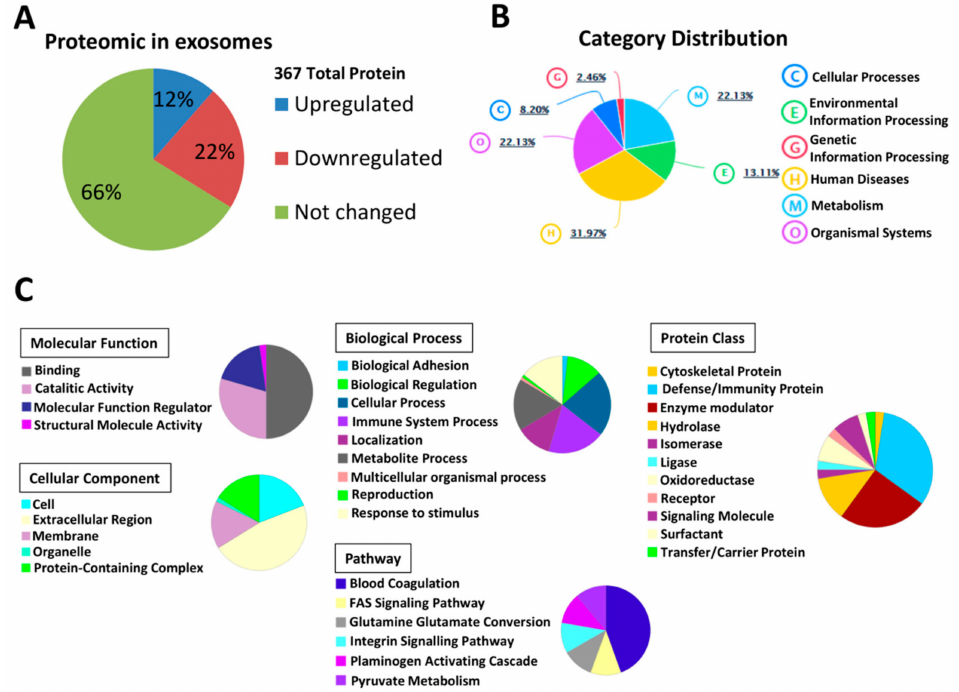
Figure 3. Proteomic profiling of extracellular vesicles purified from plasma and di ff erently expressed in hyperammonemic rats respect to control. ( A ) Number of total proteins identified and percentage of up-regulated and down-regulated proteins, ( B ) Category distribution from Paintomics analysis and ( C ) Gene Ontology (GO) analysis to determine molecular function, cellular components, biological processes, pathways and protein class for the 124 proteins di ff erently expressed in hyperammonemia, plotted with the percentage of each